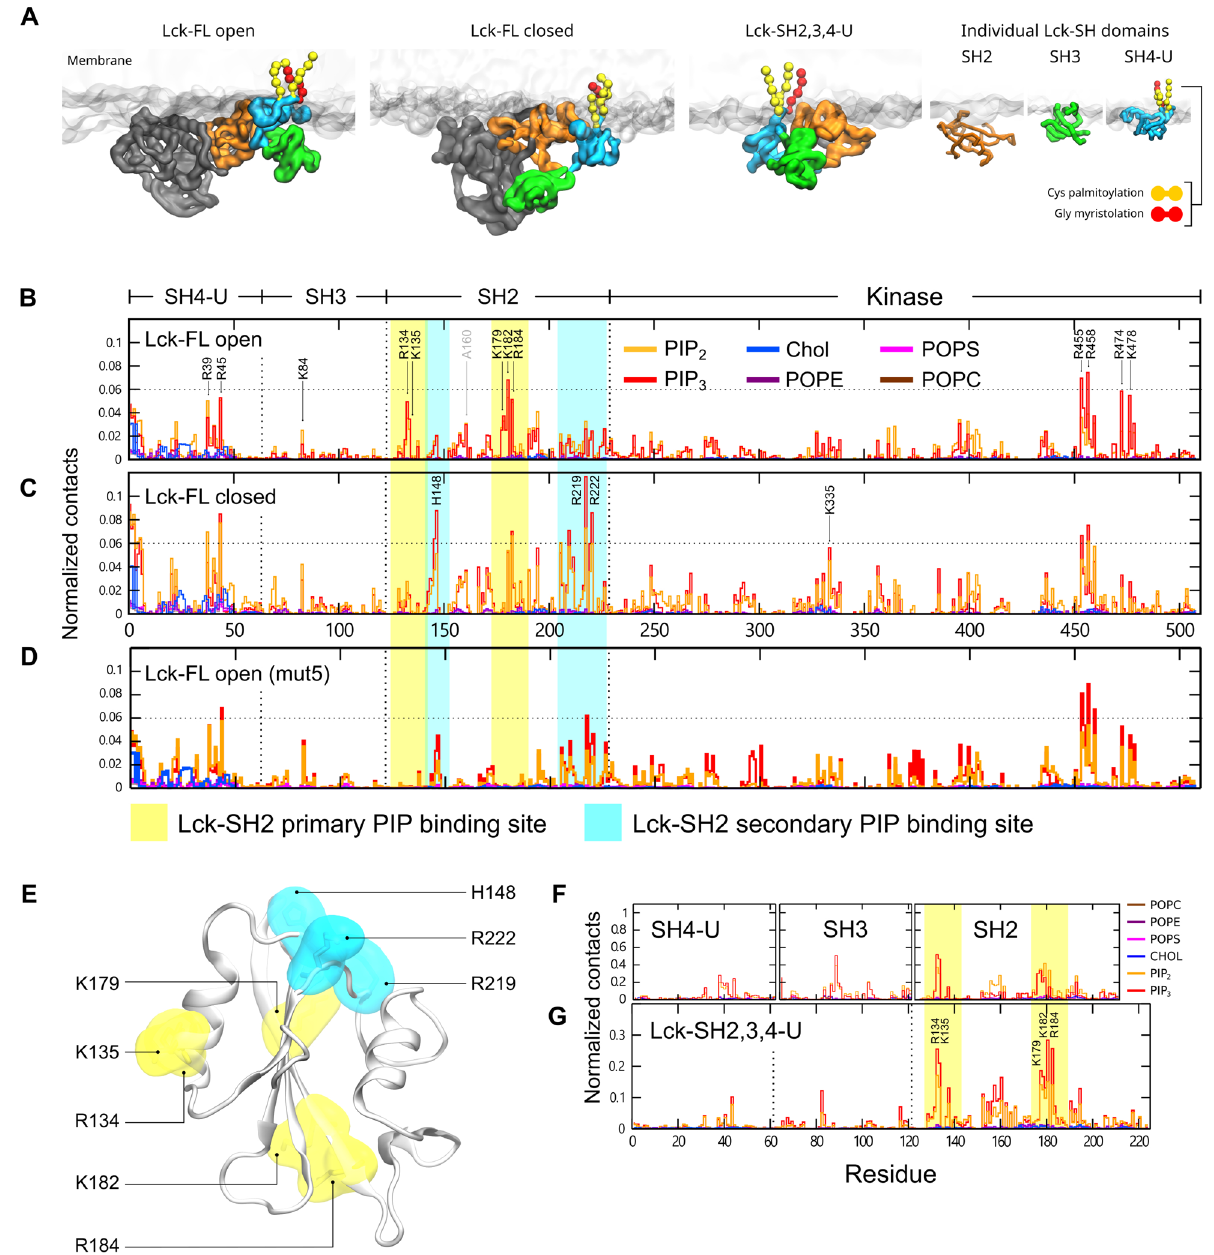
Figure 3. Snapshots of the initial simulation setup and PIP lipid binding sites. ( A ) The final snapshots from one of the simulations of the open and closed conformations of Lck-FL. Also, the final frames of one of the simulations of the Lck-SH domains combined (SH2, SH3, SH4-U) and of the individual Lck-SH domains where the protein structure was initially placed in solution ~ 6 nm away from the membrane. ( B ) Normalized lipid interactions of Lck-FL open, ( C ) Lck-FL closed, ( D ) Lck-FL open when mutated (mut5 i.e., R134A, K135A, K179A, K182A, R184A), ( E ) Residues constituting the primary (yellow) and secondary (cyan) PIP lipid binding sites of Lck-SH2 as observed in CGMD simulations of Lck-FL open and closed. See Fig. S2A for a magnified view of lipid interactions other than PIPs. ( F ) Normalized lipid interactions of the SH4-U, SH3, SH2 domains when individually simulated, and ( G ) of the SH4-U, SH3, SH2 domains simulated in conjunction (Lck-